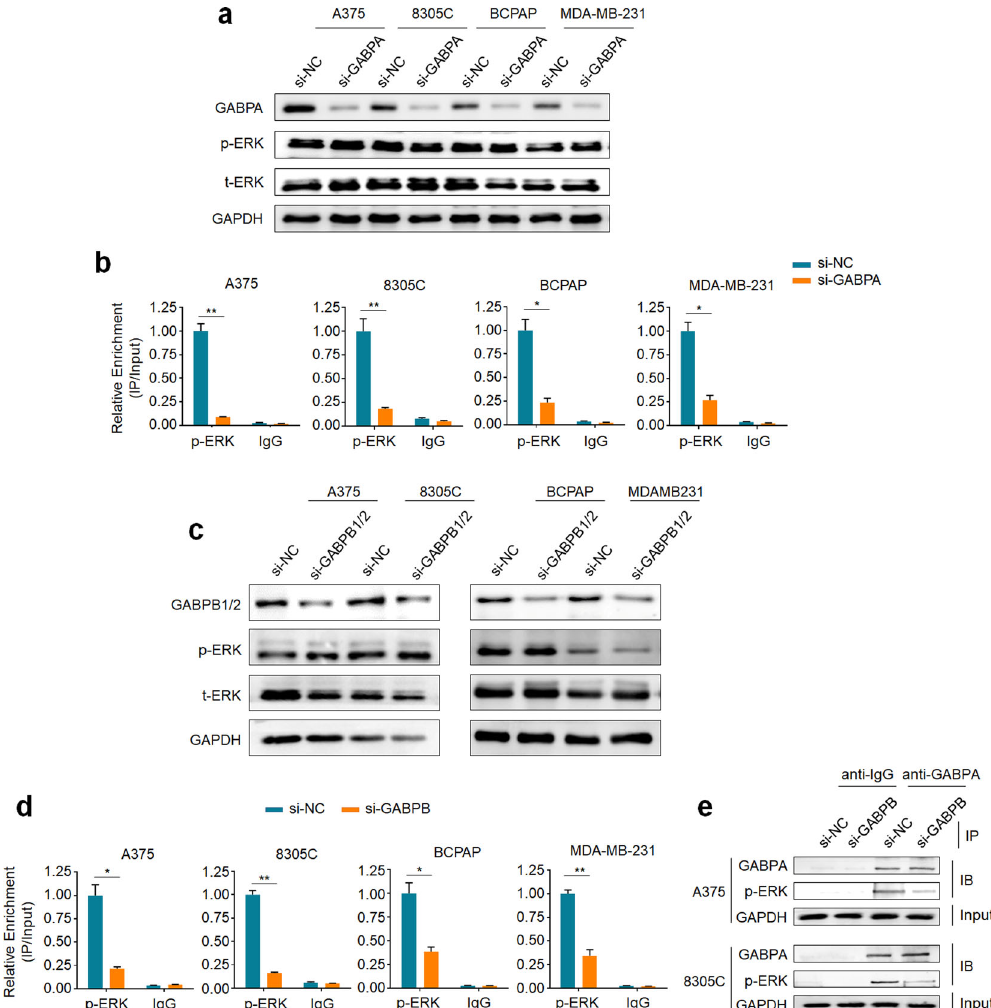
Fig. 1 GABP tetramer mediates the recruitment of activated ERK to mutant TERT promoter. a Western blot was performed to determine the effect of GABPA knockdown on the levels of phosphorylated ERK (p-ERK) and total ERK (t-ERK) in the indicated cell lines. b ChIP-qPCR assay was performed to evaluate the effect of knocking down GABPA in the indicated cancer cells on the binding of p-ERK to TERT promoter. c Western blot was used to assess the effect of GABPB1/2 knockdown on the levels of p-ERK and t-ERK in the indicated cell lines. d ChIP-qPCR assay was performed to determine the effect of GABPA knockdown on the binding of p-ERK to TERT promoter in the indicated cells. e Co-IP with indicated antibodies followed by immunoblot (IB) showing the interaction between GABPA and p-ERK in A375 and 8305C cells knocking down GABPB and control cells. Data were shown as mean ± SD. * P < 0.05; ** P <